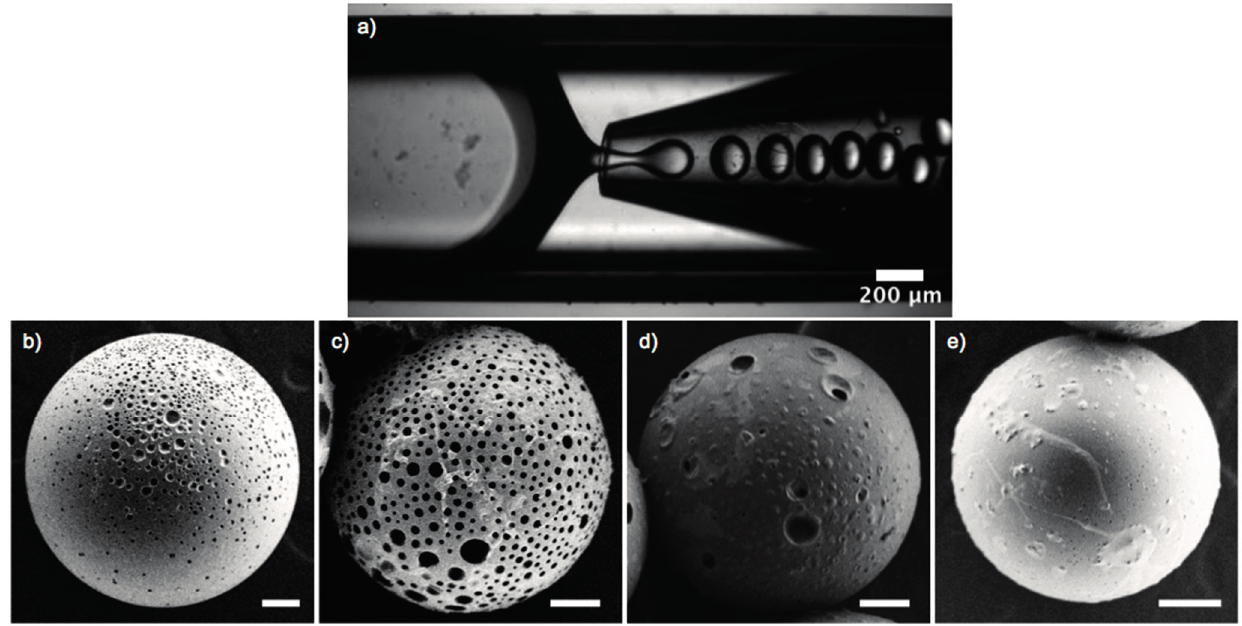
Figure 3. ( a ) Optical microscopy image of microfluidic droplet fabrication with ( b – e ). Scanning electron images of microspheres fabricated with porogens: ( b ) hPG 7.5kDa100 ; ( c ) hPG 13kDa100 ; ( d ) dPG [G3.5] ; and ( e ) hPG 7.5kDa50 . Scale bar: 10 µm.